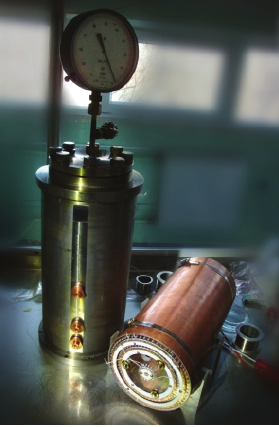
Figure 4: The counter before assembling.